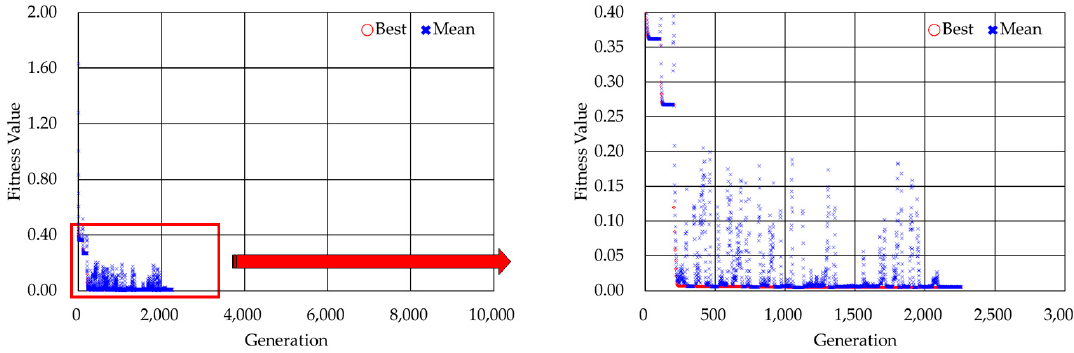
Figure 4. Fitness values at each